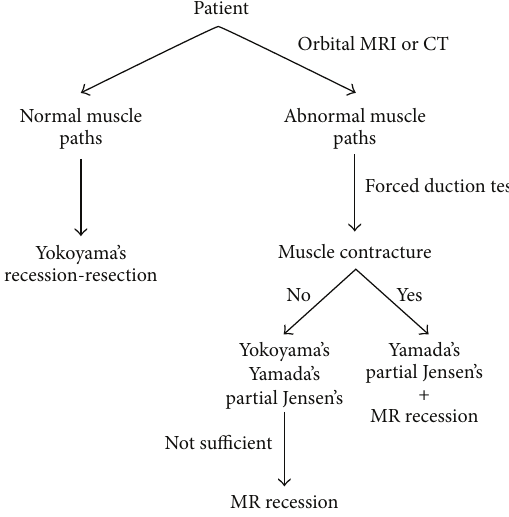
Figure 2: Flow diagram of the selecting process of surgical proce- dure. MRI or CT scan of the orbit before surgery can give a clear demonstration of the rectus muscle paths. If there is an absence of alteration in muscle paths, both Yokoyama’s procedure and traditional recession-resection surgery have been recommended in some studies. In patients with abnormality in muscle paths, if contracture of the MR muscle is found, the MR recession is recommended together with the union of the LR and SR. If there is no evidence of MR contracture, the MR recession can be staged in a second surgery when the union of LR and SR is not sufficient to correct the abnormal muscle